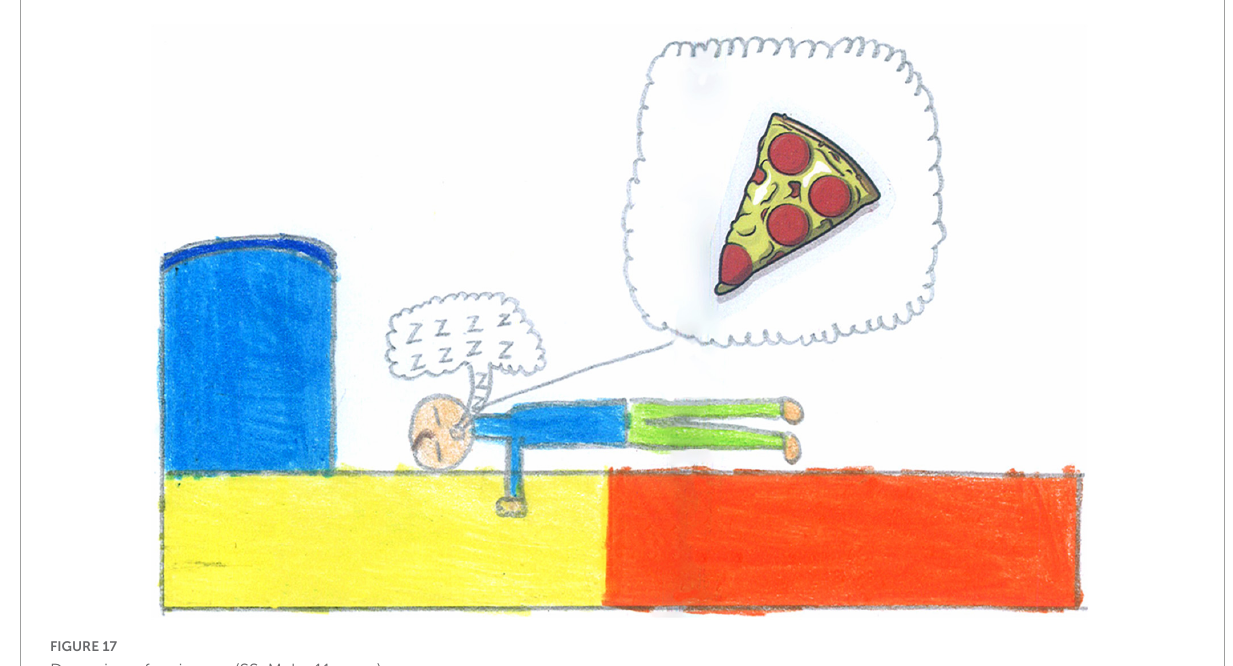
FIGURE17 Dreaming of a pizza ... (SS, Male, 11 years).